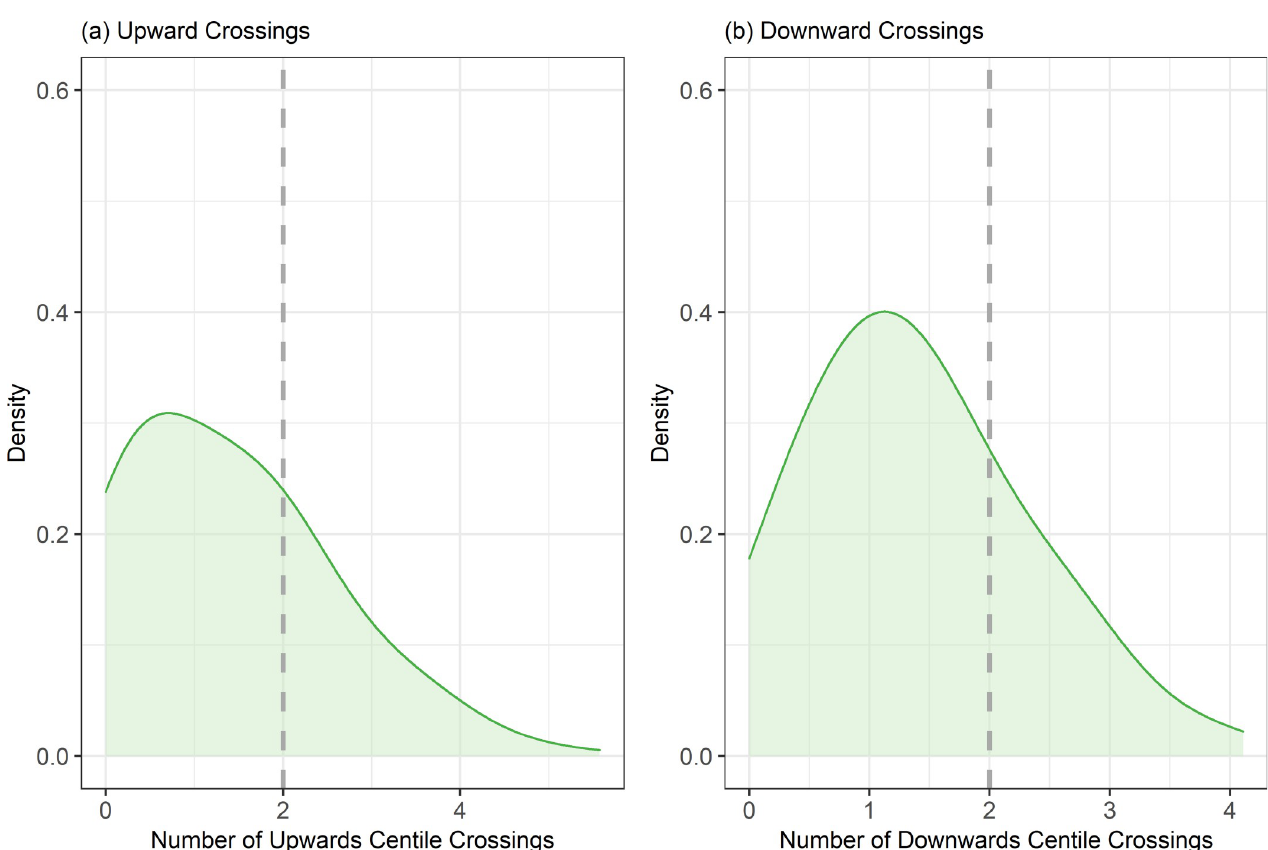
Fig 4. Density distribution of the number of standard centile lines crossed in an (a) upwards and (b) downwards direction for cats in the Research Colony data set. Plots only include kittens that had at least 3 weight measurements over 6 months in the age range 8 to 78 weeks old. The vertical dotted line indicates 2 centile